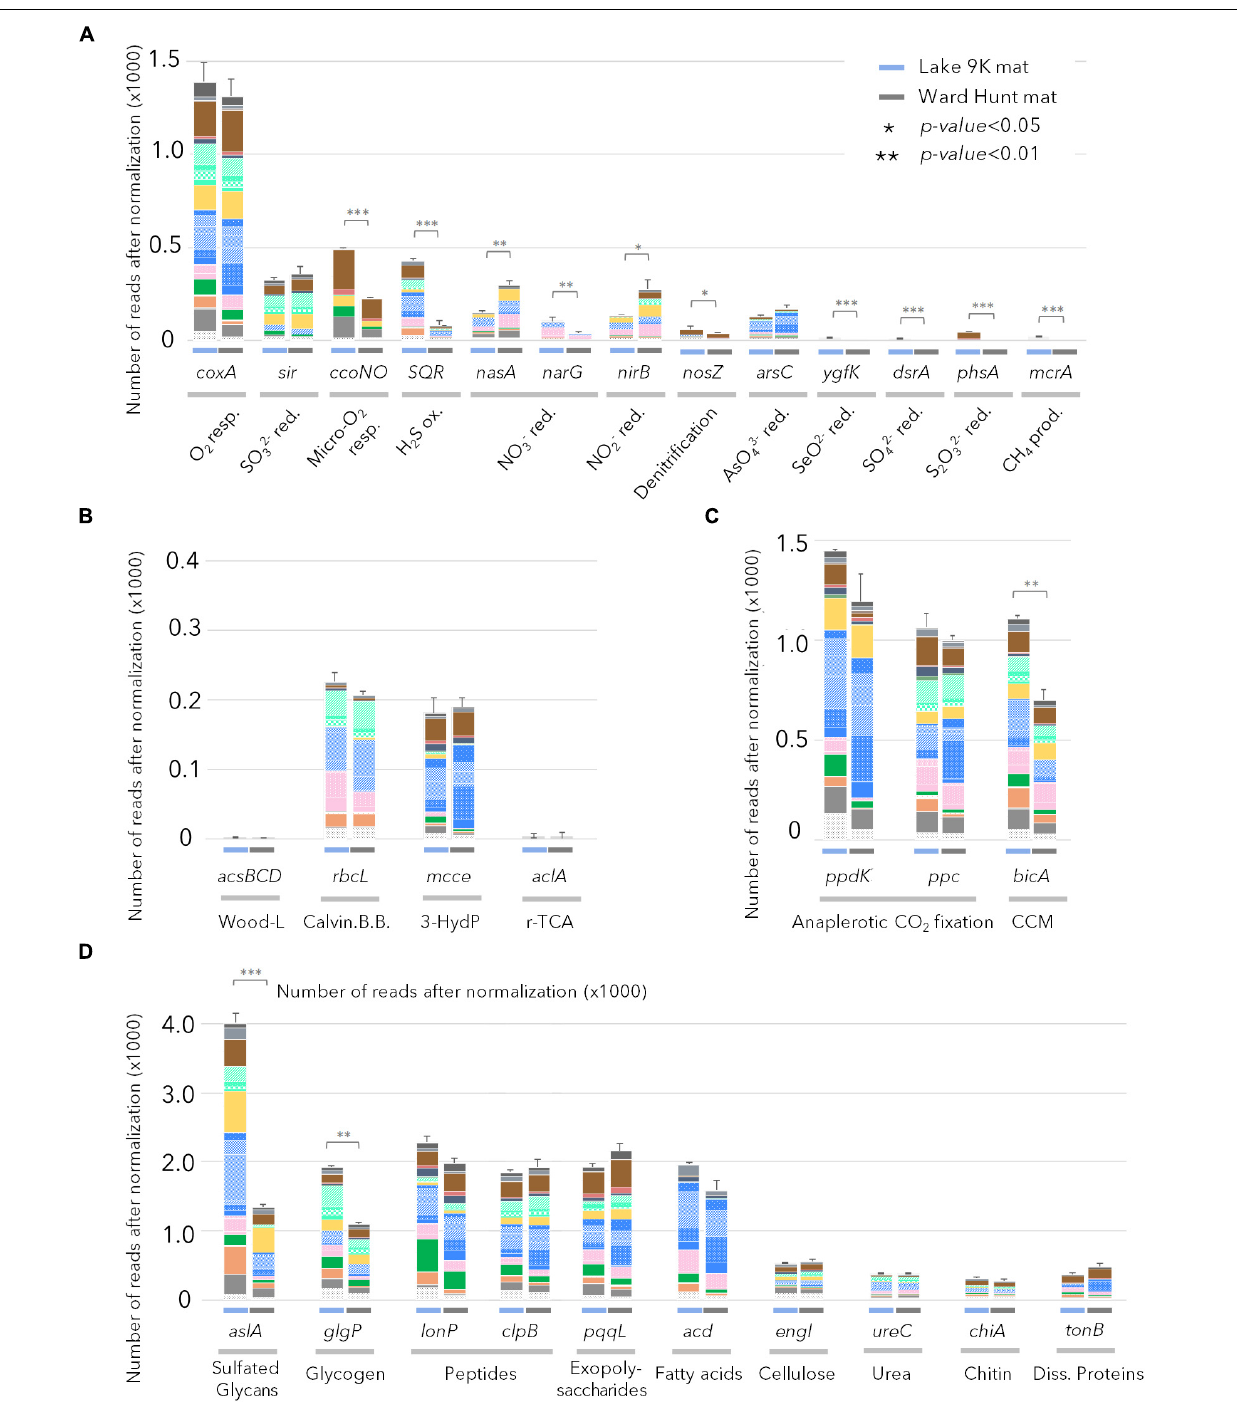
FIGURE 4 | Relative abundance of genes after normalization (see text) involved in (A) chemotrophic pathways; (B) autotrophic carbon fixation pathways (Wood-Ljungdhal pathway, Calvin-Benson-Bassham cycle, 3-Hydroxypropionate cycle and reverse citrate cycle); (C) anaplerotic carbon fixation pathways and CO 2 concentration mechanisms; (D) genes involved in complex carbon degradation detected in Lake 9K metagenomes (left bar in each pair) and Ward Hunt Lake metagenomes (right bar in each pair). Number of asterisks indicates significance of Mann–Whitney U -test between mean values from Lake 9K and Ward Hunt metagenomes ( n = 6). Resp.: respiration; red.: reduction; ox.: oxidation; prod.: production. Color code of the bars is the same as in Figure 1 with Bacteroidetes (browns), Cyanobacteria (light greens), Planctomycetes (yellow), Alphaproteobacteria (blue), Betaproteobacteria (pink), Deltaproteobacteria (dark green), Gammaproteobacteria (orange), and Verrucomicrobia